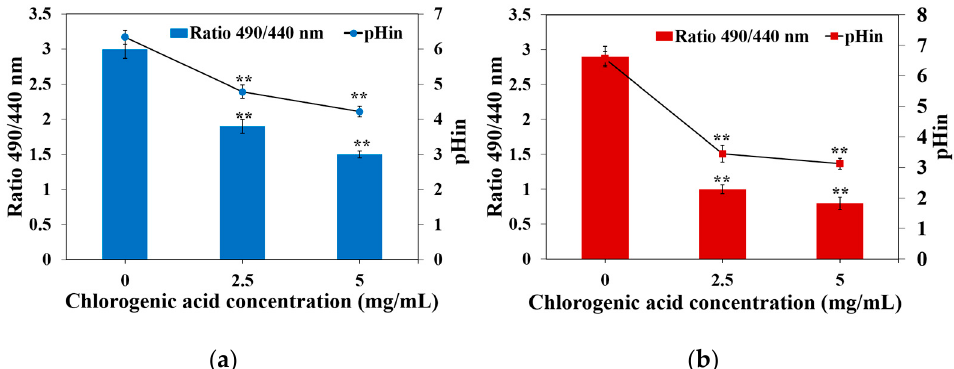
Figure 4. Effect of CA on the intracellular pH level of ( a ) Y. enterocolitica and ( b ) E. sakazakii . Error bars represent the standard deviation ( n = 3). ** p ≤ 0.01 represent significant differences between the treatment group and control group.